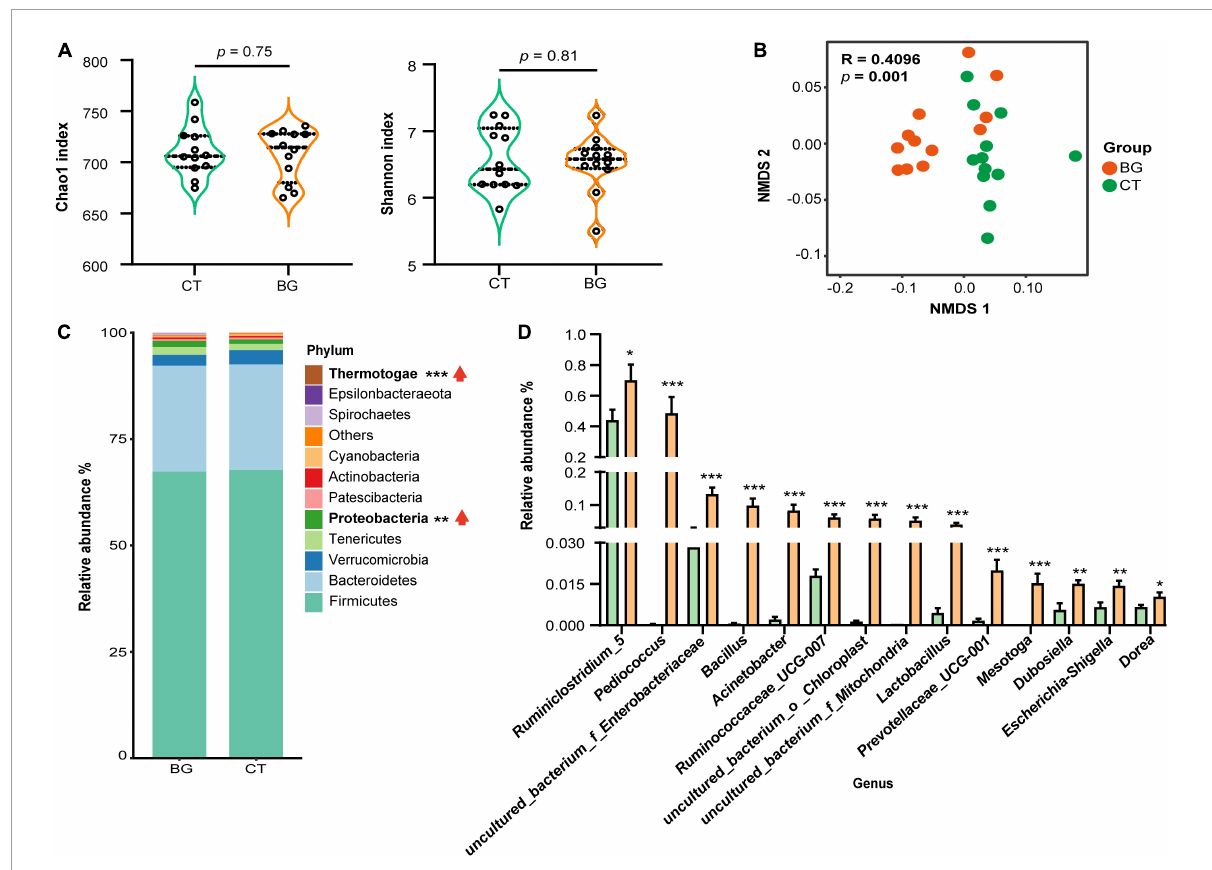
FIGURE2 Oat β -glucan altered gut microbiota abundance of weaned rabbits. (A) Alpha-diversity of bacterial communities in colon. (B) Non-metric multidimensional scaling (NMDS) analysis plots of bacteria communities in oat β -glucan (BG) and control (CT) groups. (C) The abundance of gut microbiota at the phylum level. (D) Differential gut bacteria at the genus level. * p < 0.05, ** p < 0.01, and *** p < 0.001. The upward red arrow indicates the relative abundance of this phylum was increased after feeding oat β